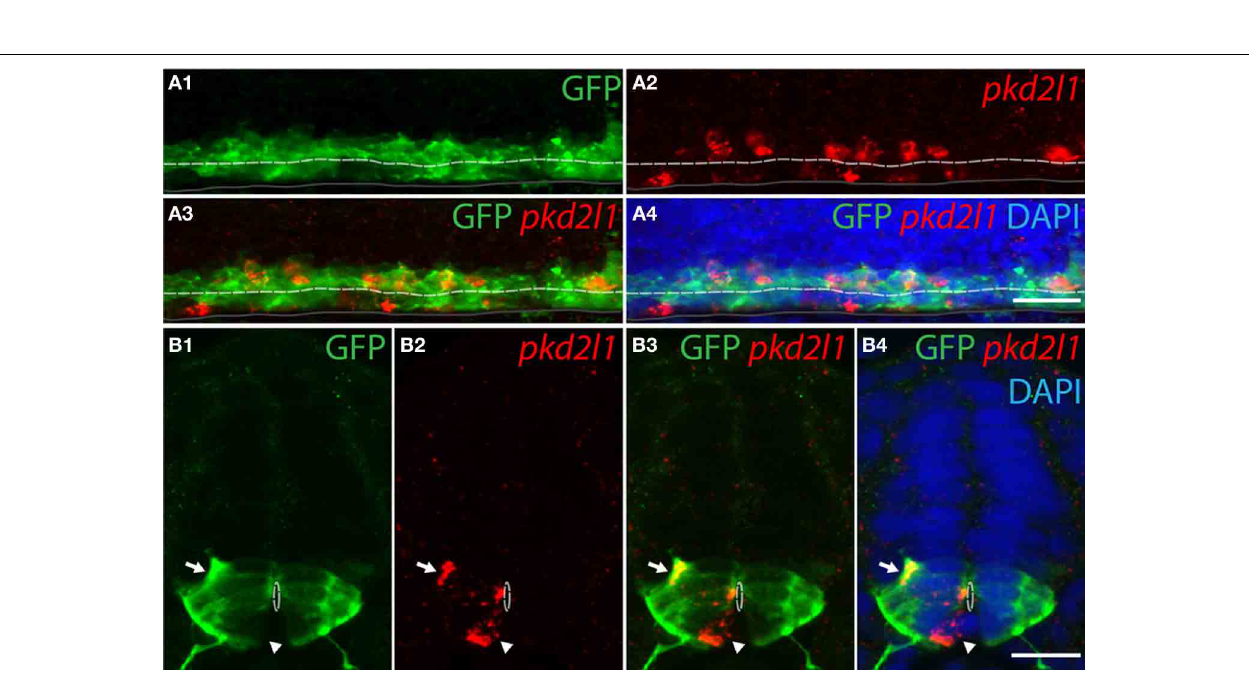
a ventral pkd2l1 + cell contacting the central canal and expressing GFP (arrowhead) while a dorsal pkd2l1 + cell contacting the central canal does not express GFP (arrow) in the Tg(nkx2.2a: mEGFP) transgenic embryo. White dashed line delineates the central canal, dark line the ventral limit of the spinal cord. DAPI staining appears in blue. Scale bars = 20 μ m.